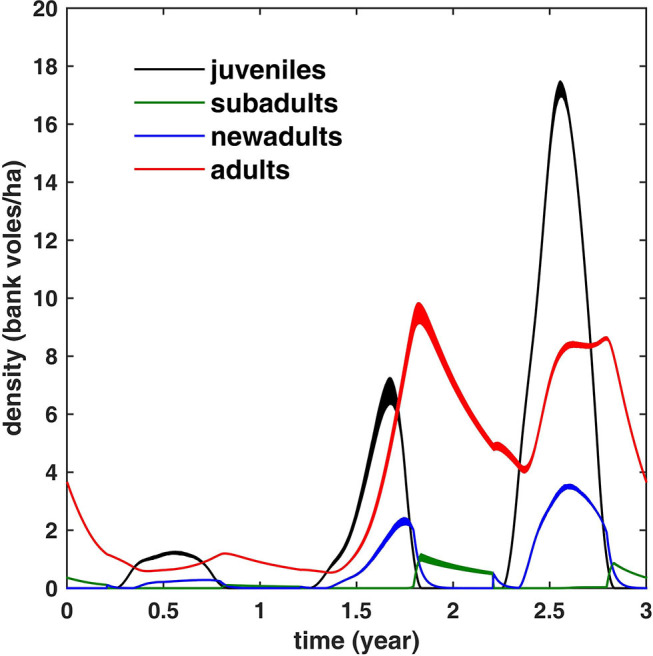
The simulated bank vole density during a 3 years cycle for different life stages (averaged over 100 cycles; the width equals twice the standard deviation). Note that adult density is limited to ≈10 bank voles/ha. In winter, all juveniles have turned either to adults or subadults; the latter mature (and turn into new adults) in spring.